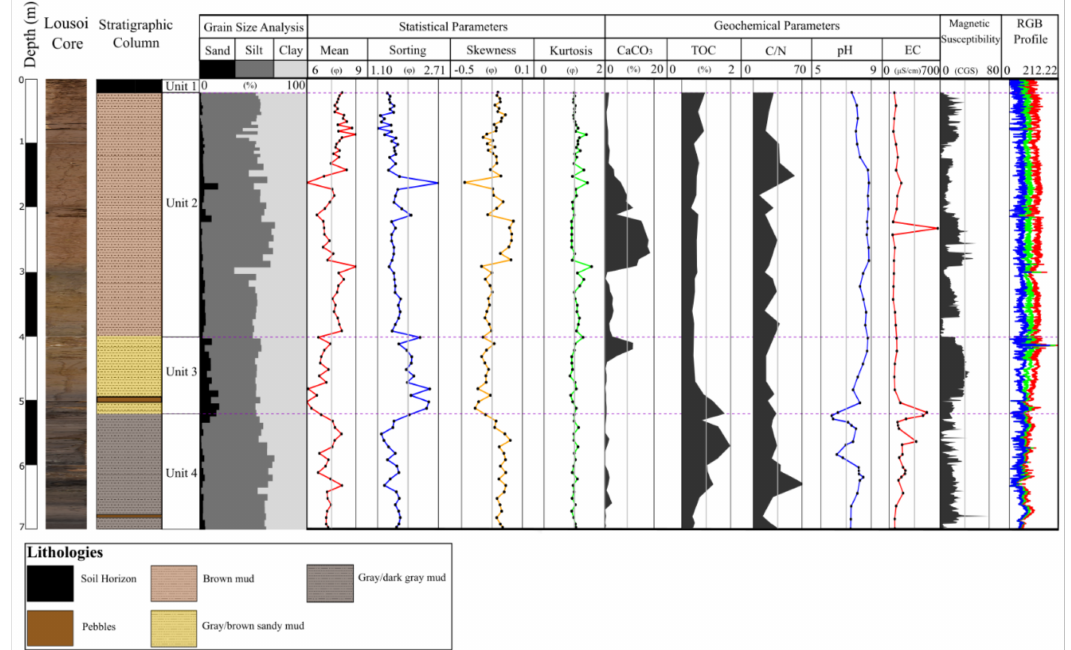
Figure 4. Log profile of core LS. From left to right, LS core photograph, stratigraphic column with the main units recognized, grain size distribution and statistical parameters, geochemical parameters (CaCO 3 , TOC, C/N, pH, EC), magnetic susceptibility (MS) values, and RGB profile